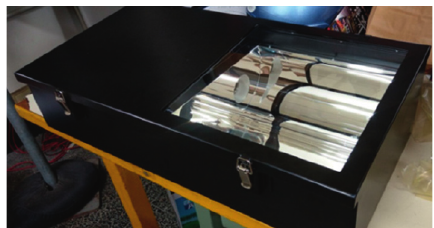
Figure 13: The prototype of the optimized CBL light.